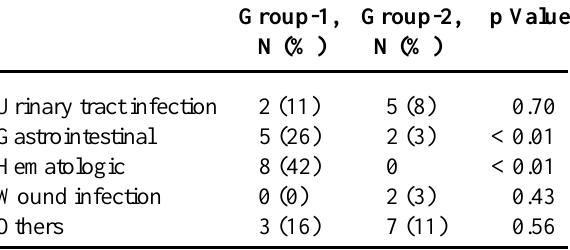
Table 3 – Complications.